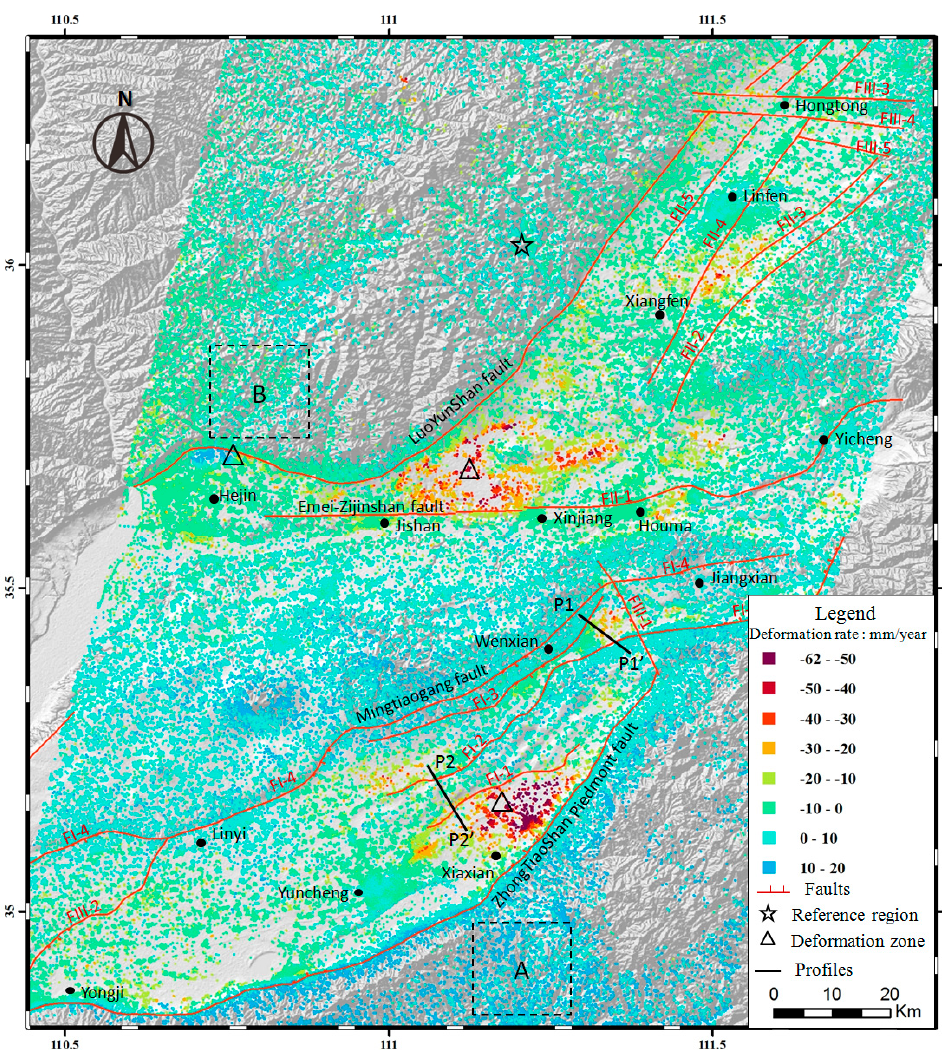
Figure 3. Mean velocity of the Linfen–Yuncheng basin derived from the InSAR time series.